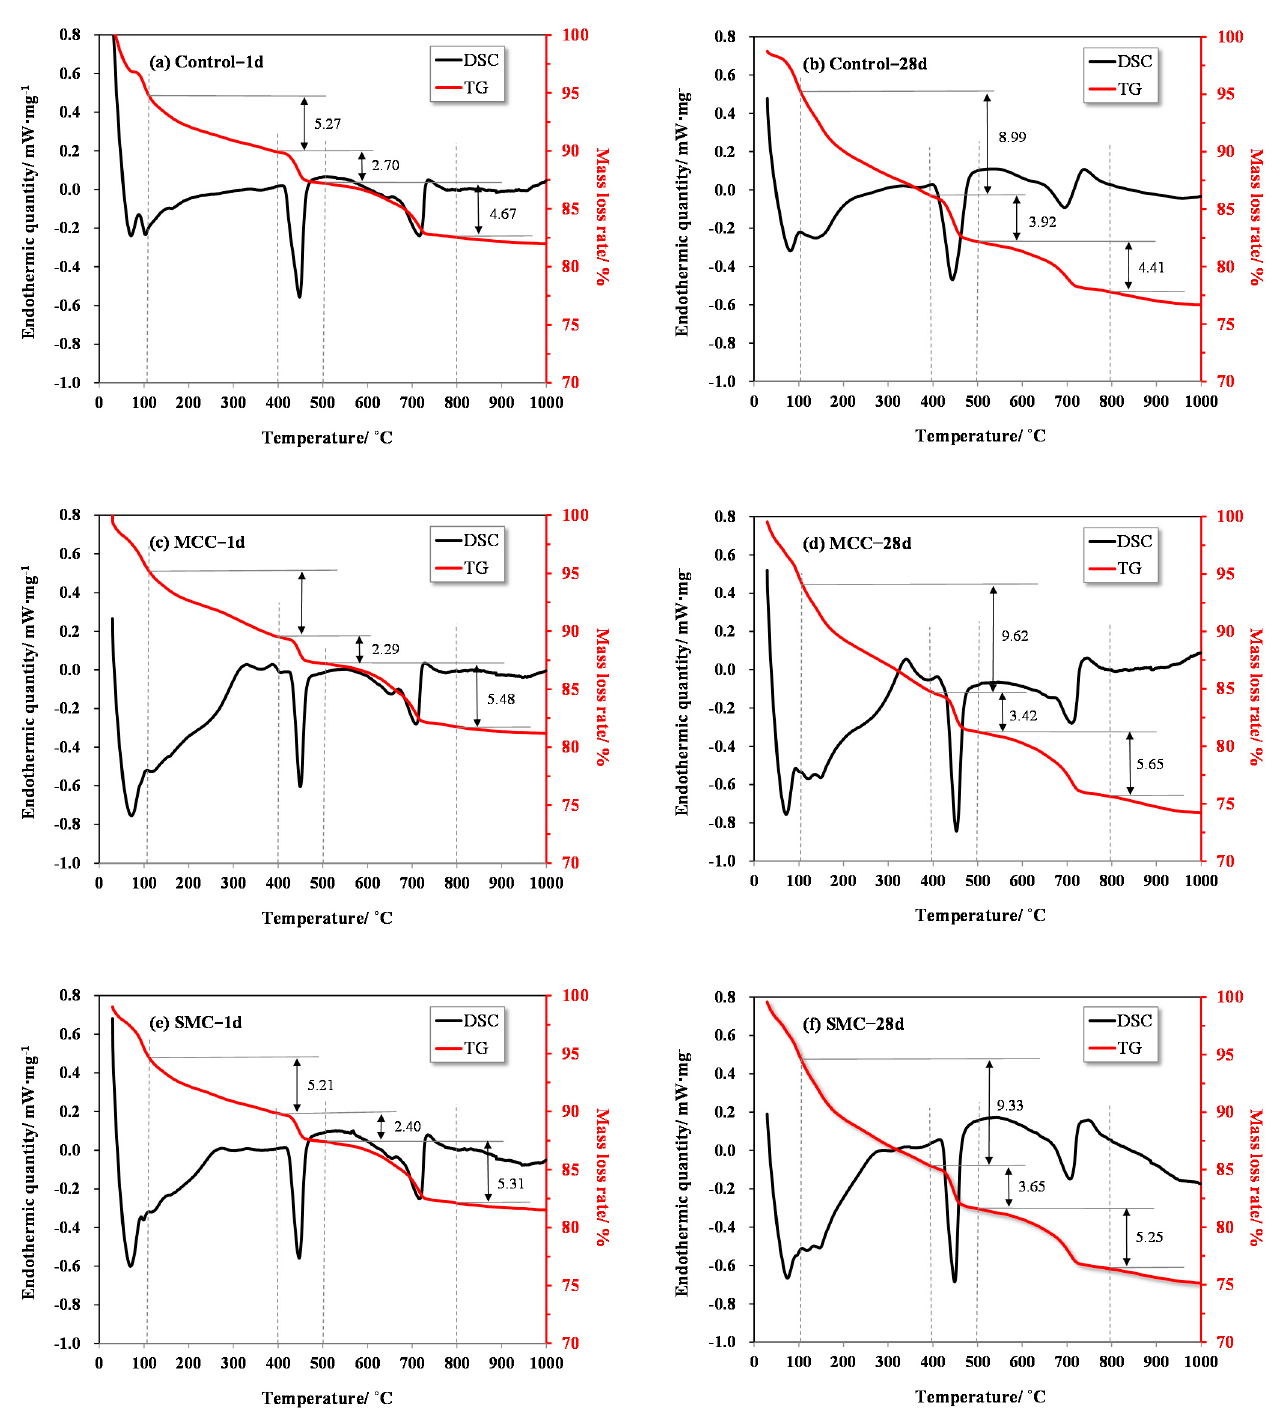
Figure 7. DSC analysis of control pastes and cement pastes with SMC and MCC fibers at the age of 1 day and 28 days. DSC curves exhibit four distinct stages in the decomposition of the control paste, the MCC cement paste and the paste with SMC fibers: (1) at temperatures between 20 and 105 °C, which is related to free water; (2) at temperatures between 105 and 400 °C, which is related to the dehydration of C-S-H gel and decomposition of AFt, AFm and gypsum; (3) temperatures between 400 and 500 °C, which correspond to the decomposition of CH (weight loss L CH ); (4) temperatures between 670 and 780 °C, which correspond to the de- composition of CaCO 3 (weight loss L Calcite ) [48].